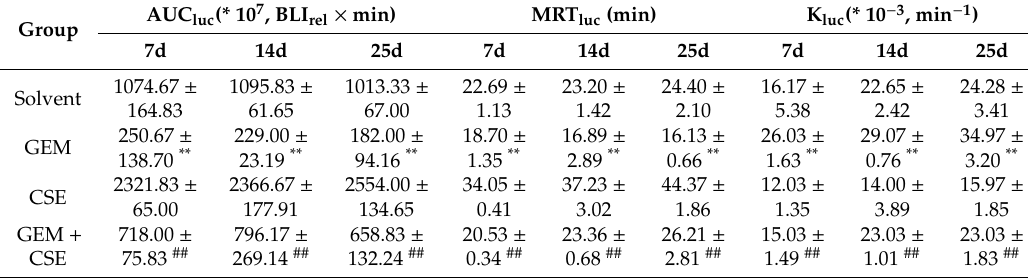
n = 6, mean ± SD. ** p < 0.01 vs. DMSO; ## p < 0.01 vs. GEM Group. The bioluminescent intensity of each group was normalized by protein concentration and regarded as relative bioluminescent intensity (BLI rel ). GEM,